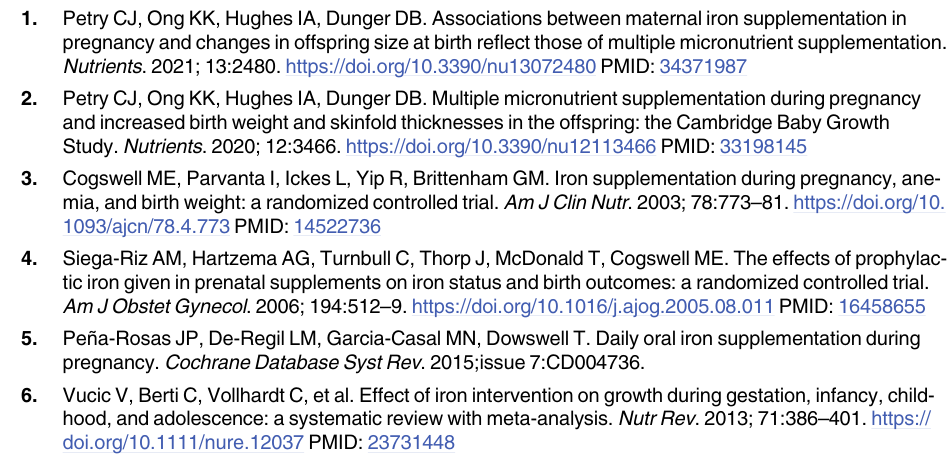
S2 Table. Associations between maternal iron supplementation status in pregnancy and markers of offspring growth at 3 months of age. S3 Table. Associations between maternal iron supplementation status in pregnancy and offspring growth and physiological measurements at around age 9.5 years in those chil- dren whose mothers did not report being anaemic in